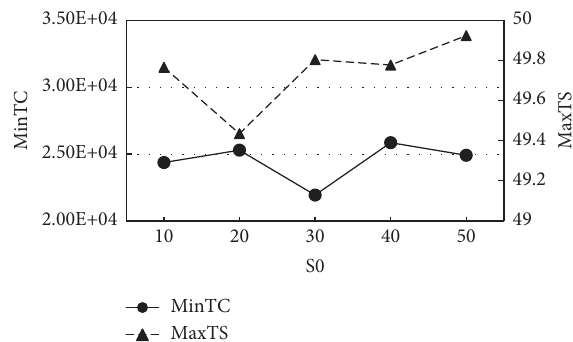
Figure 4: Sensitivity analysis of lead time. Figure